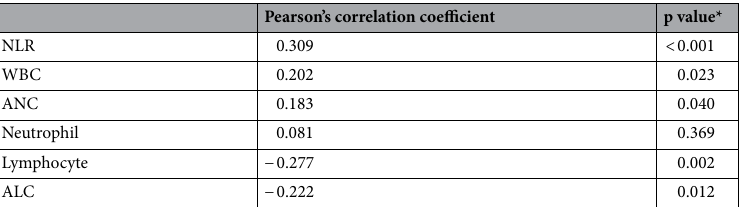
Table 4. Analysis of correlations between sPD-L1 and circulating immune cells. Two outliers with extremely high sPD-L1 levels or absolute neutrophil counts were excluded from these analyses. sPD-L1